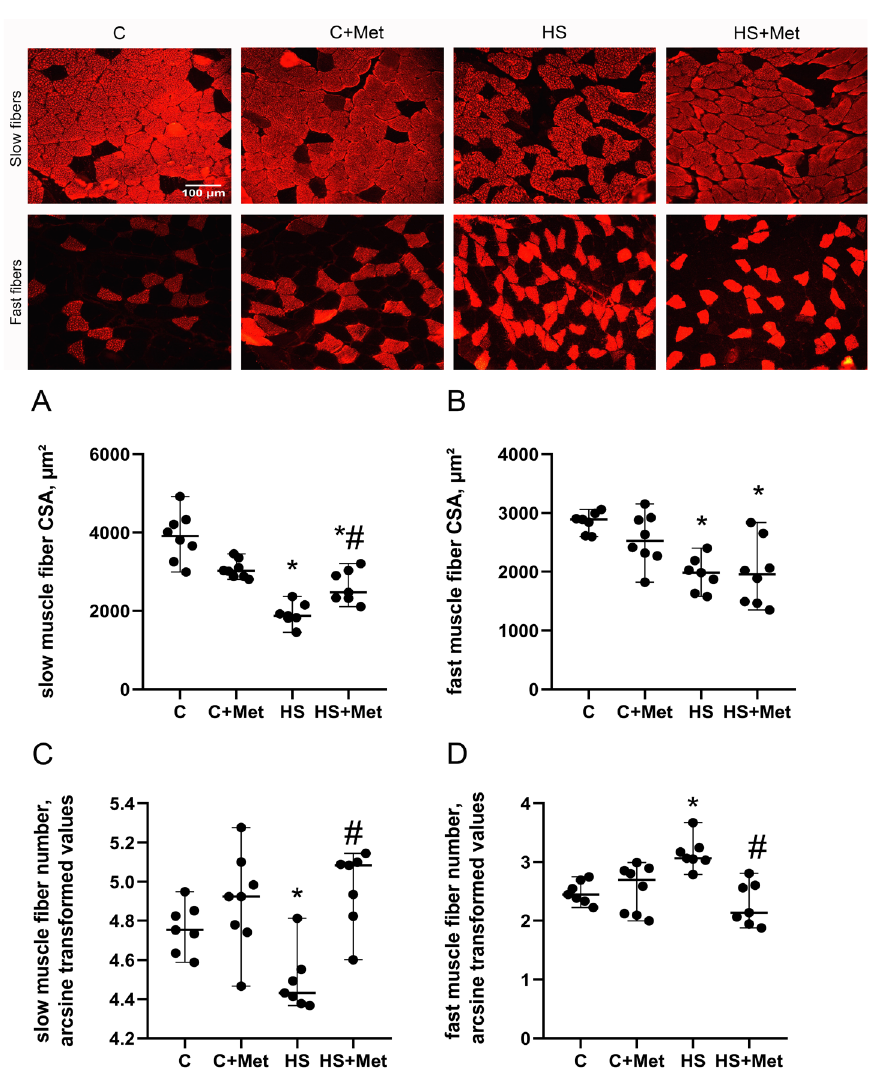
Figure 1. Cross-sectional area (CSA) of slow-type ( A ) and fast-type ( B ) fibers and the number of slow-type ( C ) and fast-type ( D ) fibers in rat soleus muscle. C, vivarium control, C+Met, vivarium control + metformin pre-treatment, HS, 7-day hindlimb suspension, HS+Met, metformin pre-treatment + 7-day hindlimb suspension. Scatter dot plots indicate median values, and the whiskers represent minimum and maximum values; n = 7–8/group. *: p < 0.05 vs. C, #: p < 0.05 vs. HS.